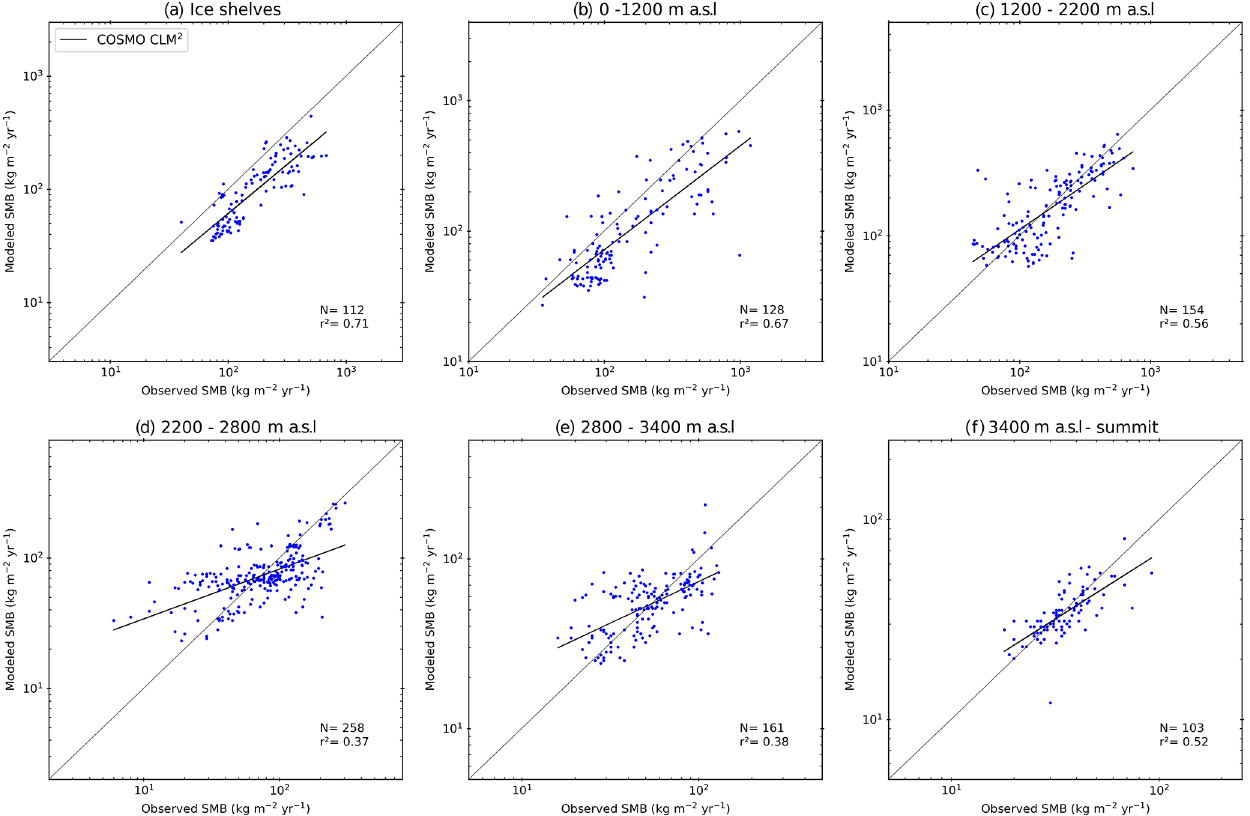
Figure A3. Comparison between COSMO-CLM 2 and observed SMB (units: kgm − 2 yr − 1 ) over the ice shelves (a) and by elevation classes (b–f) . Due to the use of logarithmic axes, only positive values for the observed and modelled SMB from all the RCMs in this study are used (number for each bin N ). Finally, the regression coefficient of each regression line is also shown ( r 2 ).